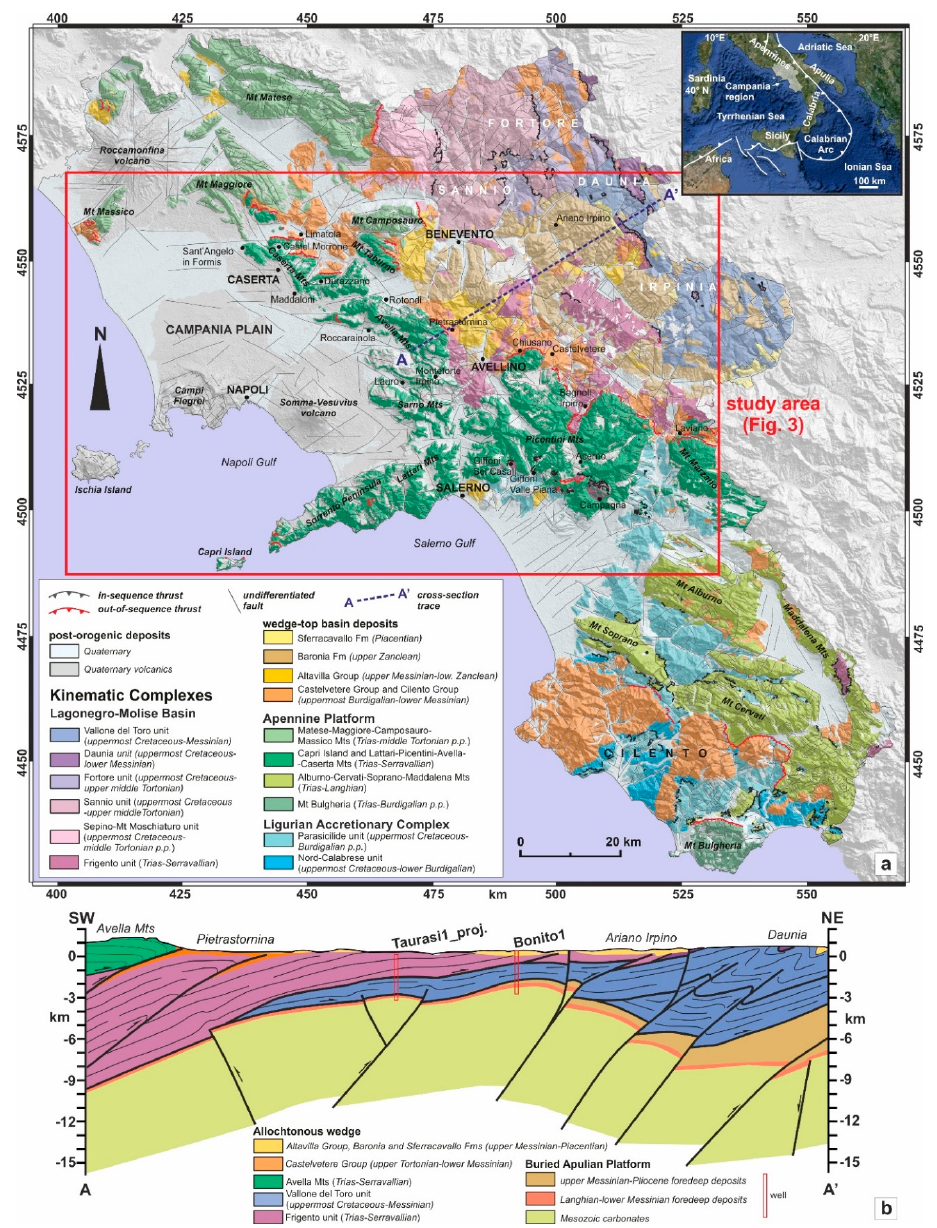
Figure 1. ( a ) Tectonic scheme of the Campania region (southern Italy), inset map of southern Italy from Google Earth. ( b ) Cross-section from Avella Mts to the Daunia sector. Modified after [19].